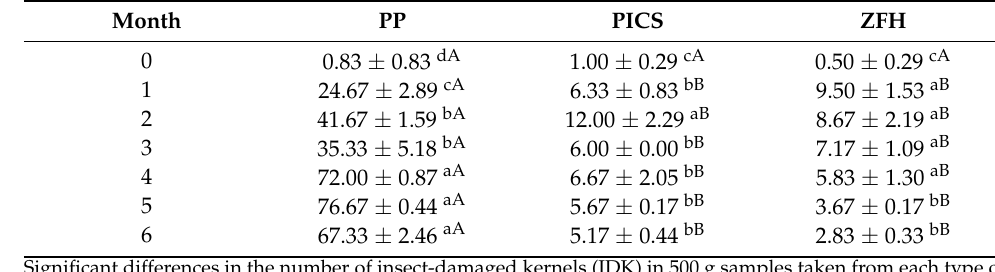
Table 3. Mean percent ( ± SE) of insect-damaged kernels (%IDK) of maize in Polypropylene (PP), Purdue Improved Crop Storage (PICS), and ZeroFly ® Hermetic (ZFH) bags sampled during